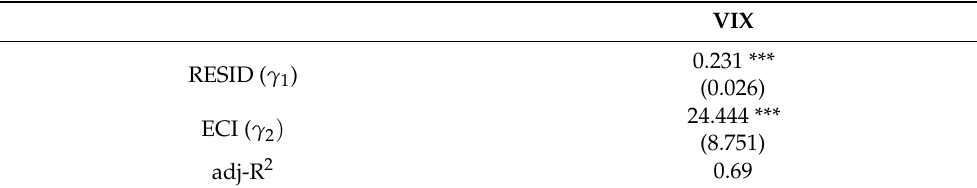
Table 4. OLS regressions of risk and uncertainty on implied